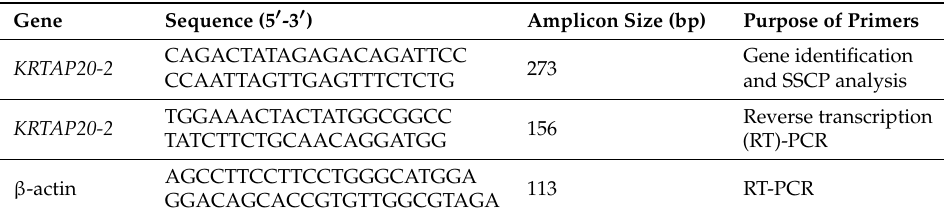
Table 1. PCR primers used in this